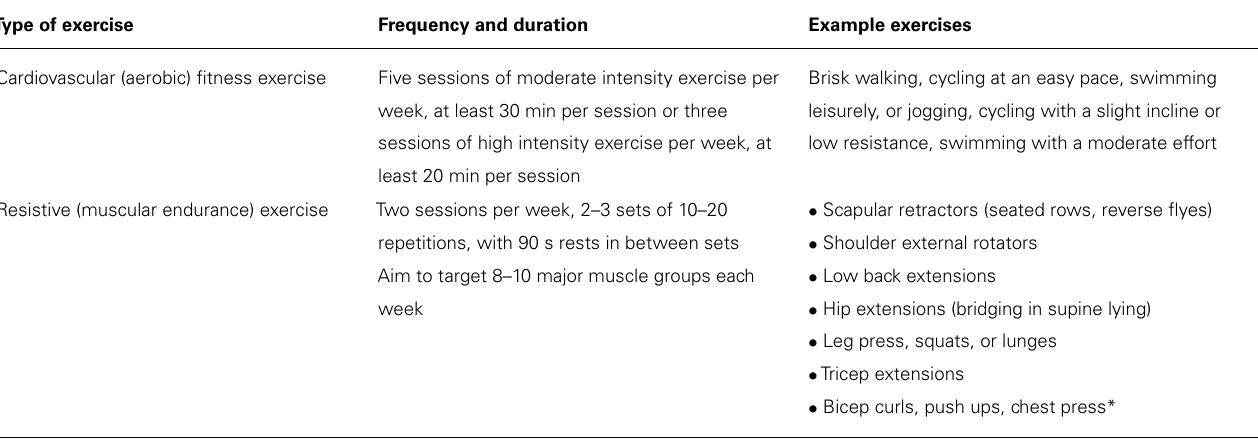
Table 2 |An exercise guideline for musicians to improve cardiovascular fitness and muscular conditioning. Type of